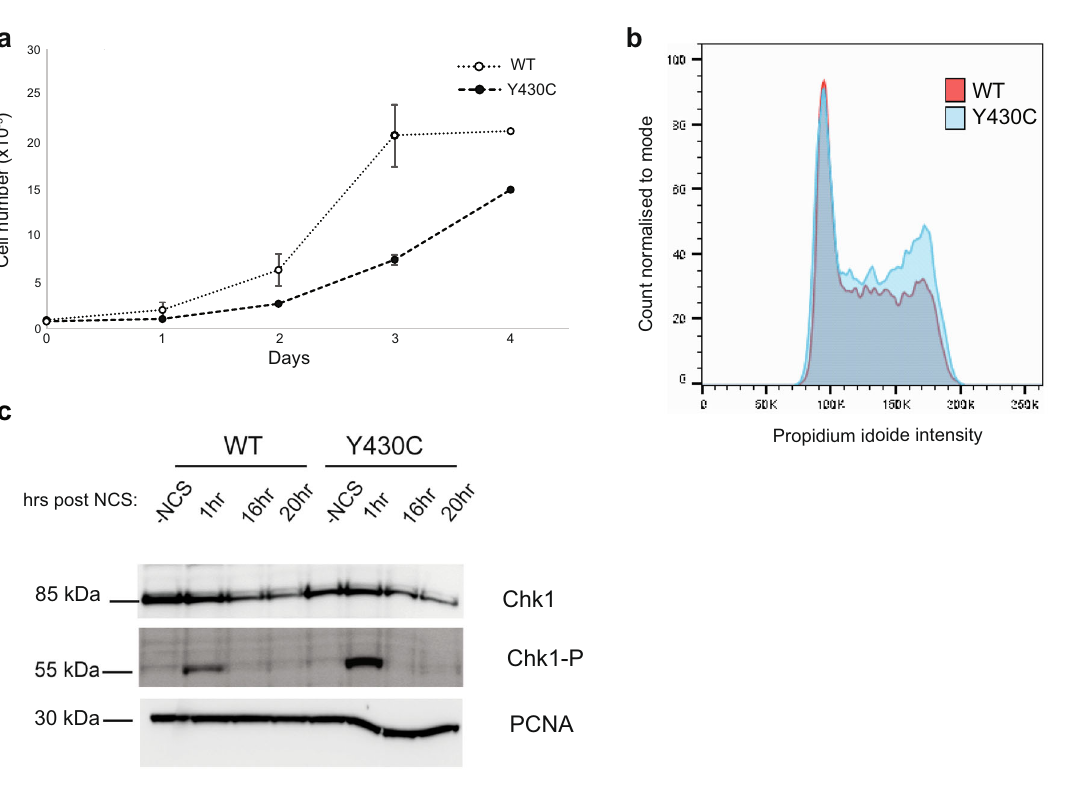
Fig. 3 Increased G2/M checkpoint activation in Y430C mESCs. a Graph shows average number of WT and Y430C cells per well at 1, 2, 3 and 4 days post seeding. Data are represented as mean ± SEM from 3 technical replicates. b Overlaid graphs show WT and Y430C cell cycle pro fi les, as determined by fl ow cytometry. Graphs illustrate the cell count, which correlates to propidium iodide intensity. Biological replicate in Supplementary Fig. 4a. c Immunoblot using antibodies against Lamin B CHK1 and CHK1-P after treatment of WT and Y430C mESCs with NCS and for various times (hrs) of recovery (source data are provided as a Source Data fi le). Data from an independent experiment are presented in Supplementary Fig.